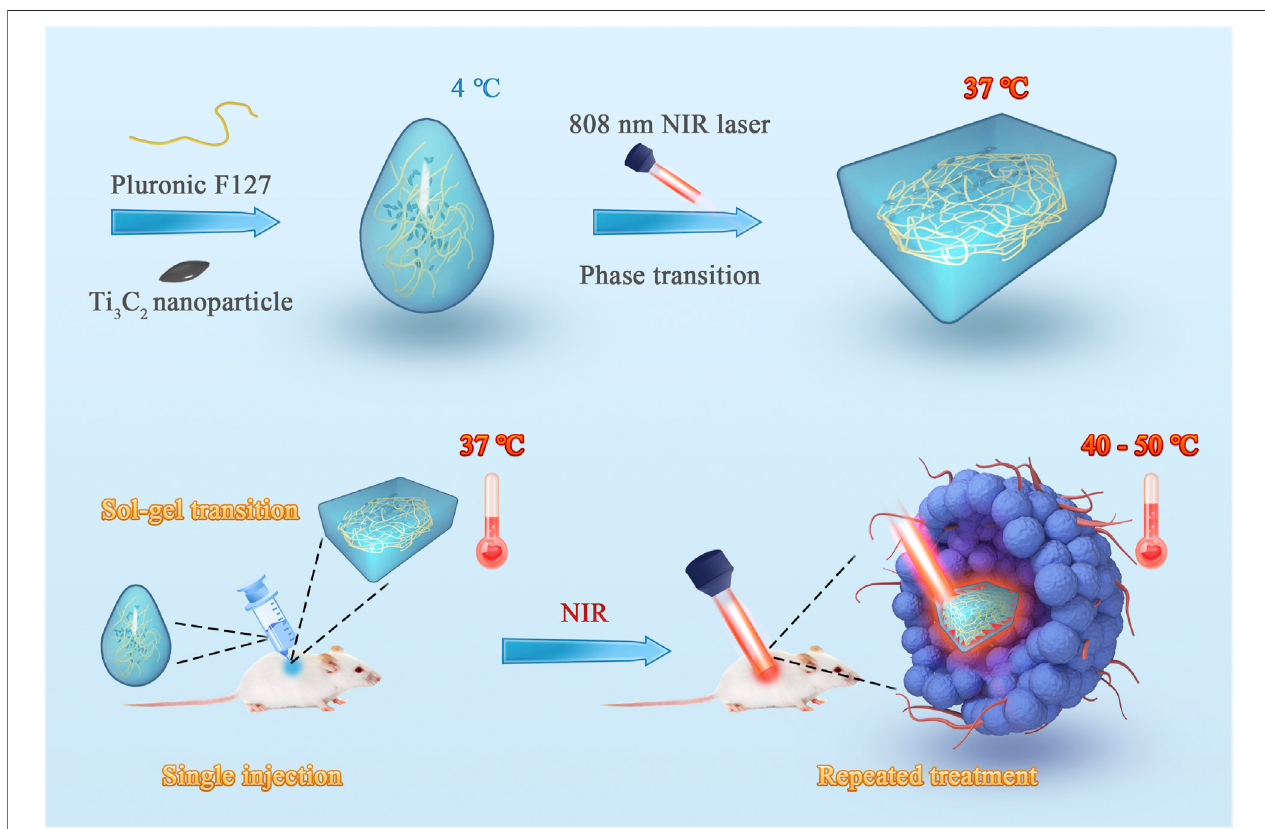
FIGURE 1 | Schematic illustration of the fabrication of the injectable hydrogel system with excellent photo – heat transition capacity. This system was fabricated usingaone-stepsynthesismethod.Ti 3 C 2 nanoparticlesandthermosensitivePluronicF127weremixedtopreparethephotothermalagent-embeddedhydrogelsystem. The system can form in situ gel in tumor tissue through sol – gel transition and prolong the retention of Ti 3 C 2 nanoparticles. Using near-infrared laser irradiation, repeated treatments can be achieved with a single